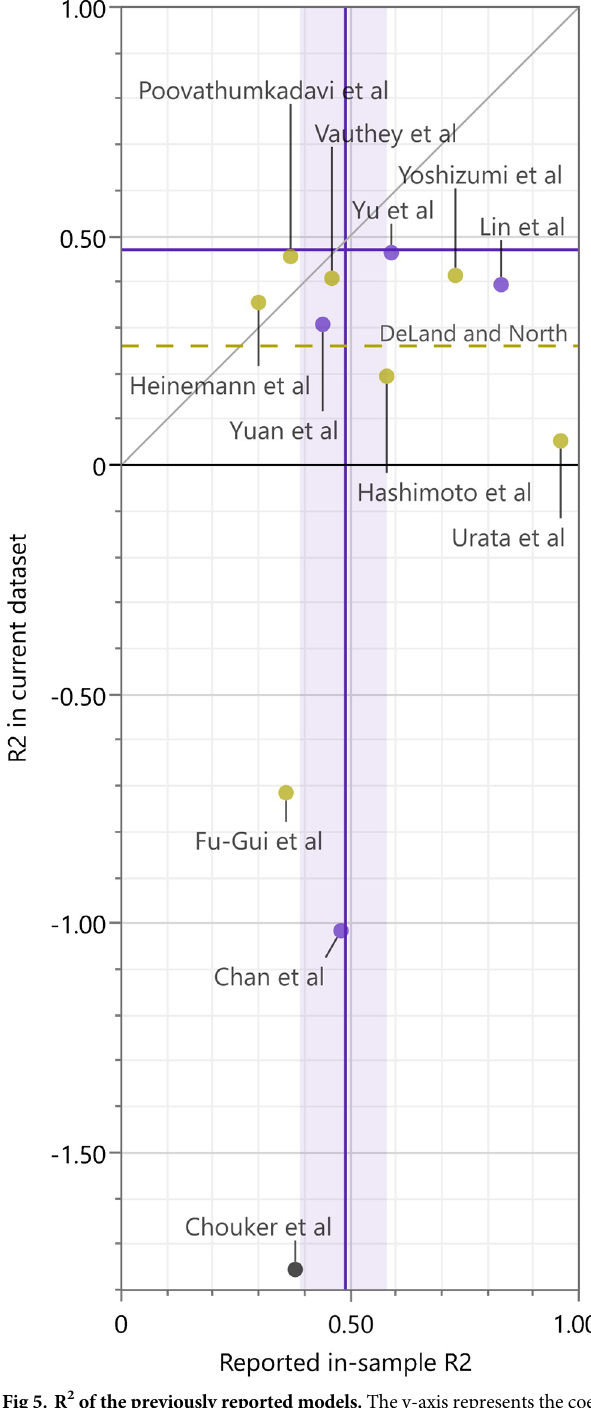
Fig 5. R 2 of the previously reported models. The y-axis represents the coefficient of determination (R 2 ) of each previously reported prediction model measured in the current whole-liver (WL) cohort. The x-axis represents the reported in-sample R 2 of previously reported prediction models, i.e., R 2 measured against the dataset with which the model was selected and fitted. The blue purple horizontal line represents cross-validation R 2 of the current model. The blue purple vertical line, with a band, represents the in-sample R 2 of the current model, i.e., R 2 of the current model measured against the current dataset, with its bootstrap 95% range. The dark yellow dashed horizontal line represents the R 2 from the prediction model of DeLand and North in the current dataset (these authors did not report in-sample R 2 ). The color of the dots represents the number of independent variables used in each prediction model. Dark yellow: 1; blue purple: 2; black: 3 or more. R 2 , coefficient of